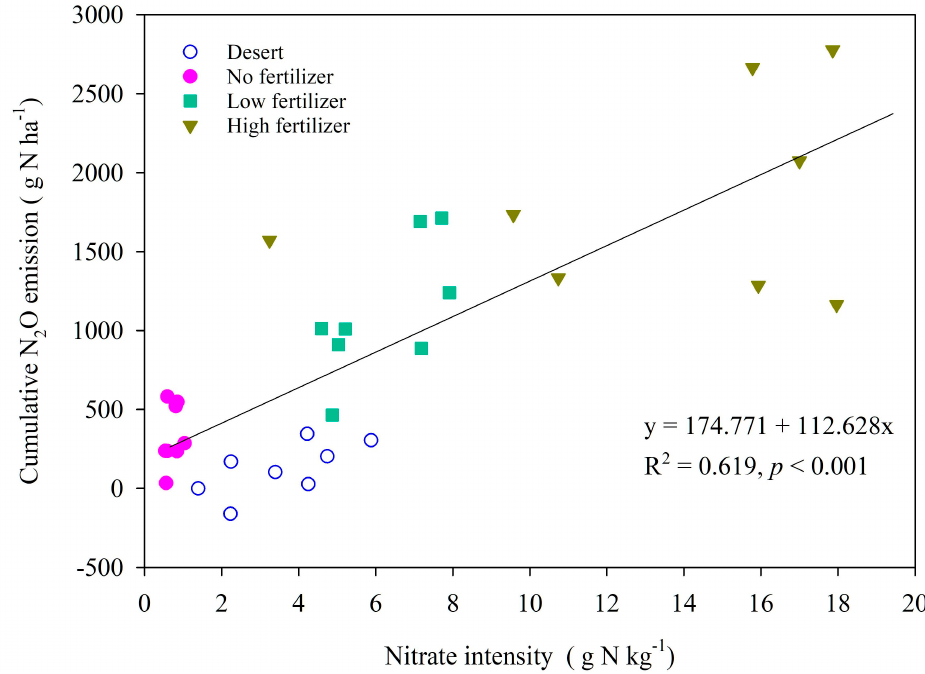
Figure 5. Relationship between the cumulative N 2 O emission and nitrate intensity from 2019 to 2021.